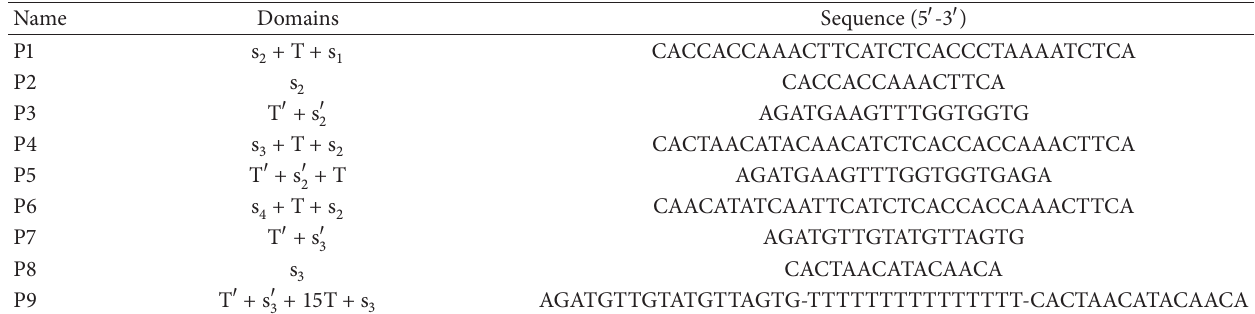
Table 1: Sequences of the DNA strands.